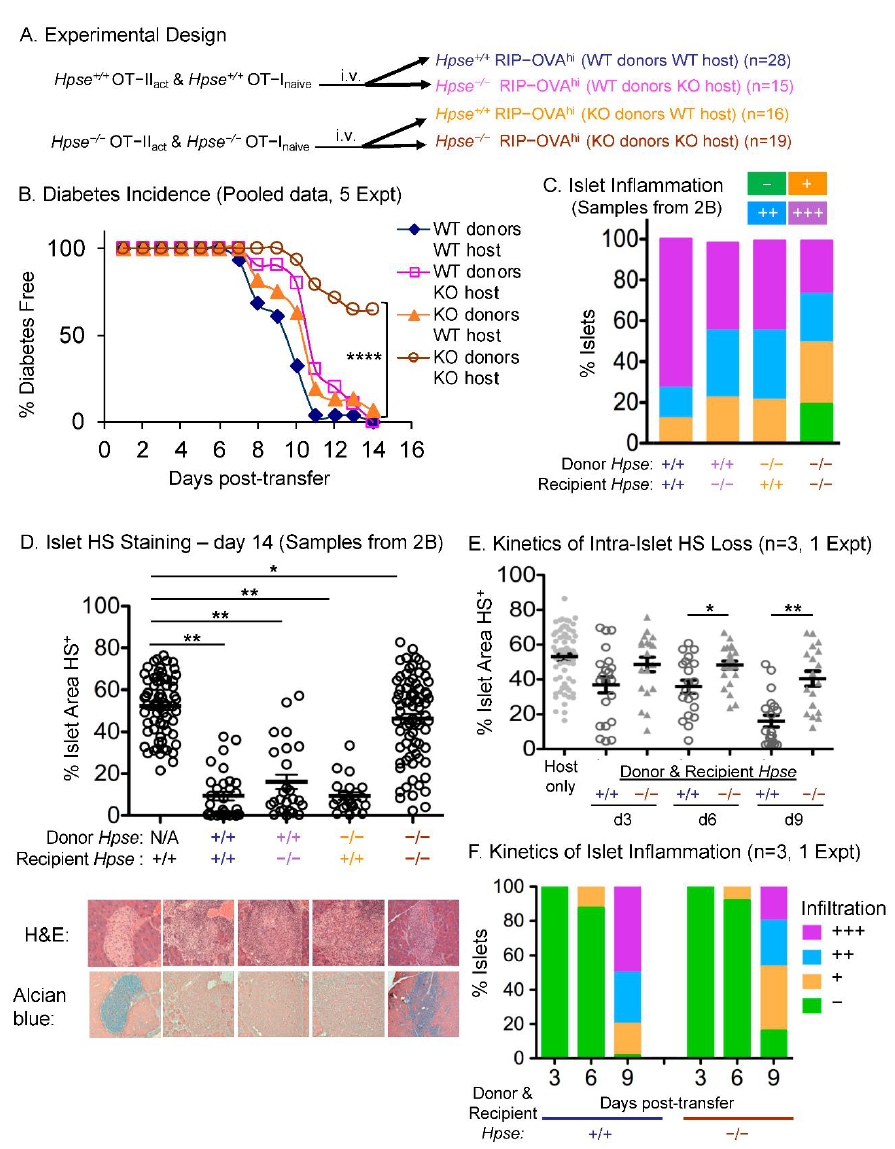
Figure 2. HPSE-1 drives antigen-specific T cell induction of T1D. ( A ) Experimental design. HPSE-1 WT or deficient naïve OT-I and activated OT-II cells were each injected into two groups of HPSE-1 WT and deficient RIP-OVAhi mice. ( B ) Diabetes incidence. WT donors and hosts (blue n = 28), WT donors and HPSE-1 deficient hosts (purple n = 15), HPSE-1 deficient donors and WT hosts (orange n = 16), deficient donors and hosts (brown n = 19). Results were pooled from 5